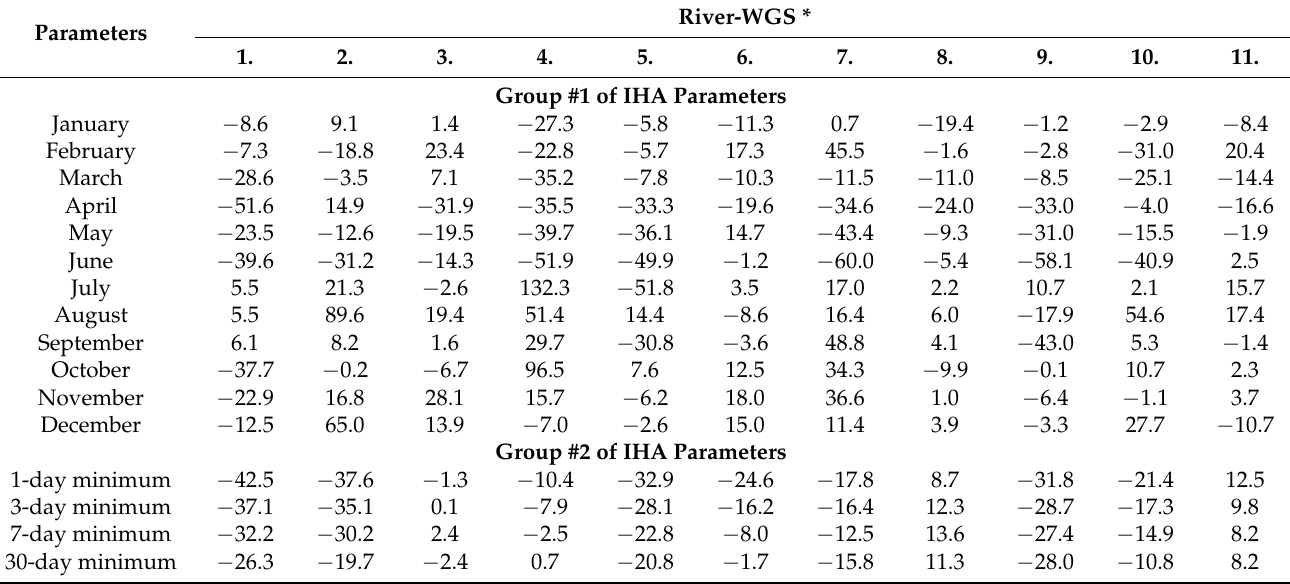
Table A1. Change (%) in the mean values of IHA